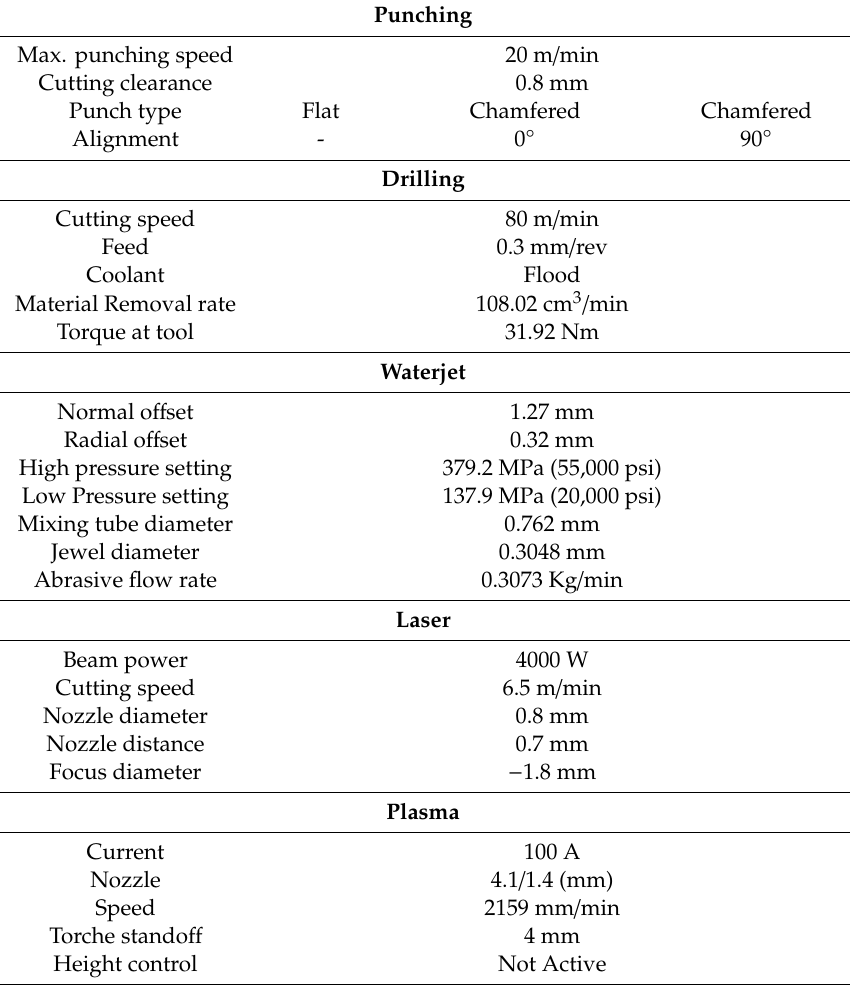
Figure 2. ( a ) Flat punch and ( b ) chamfered punch end geometry (Unit: mm). Table 2. Cutting process parameters for S700MC and S960MC